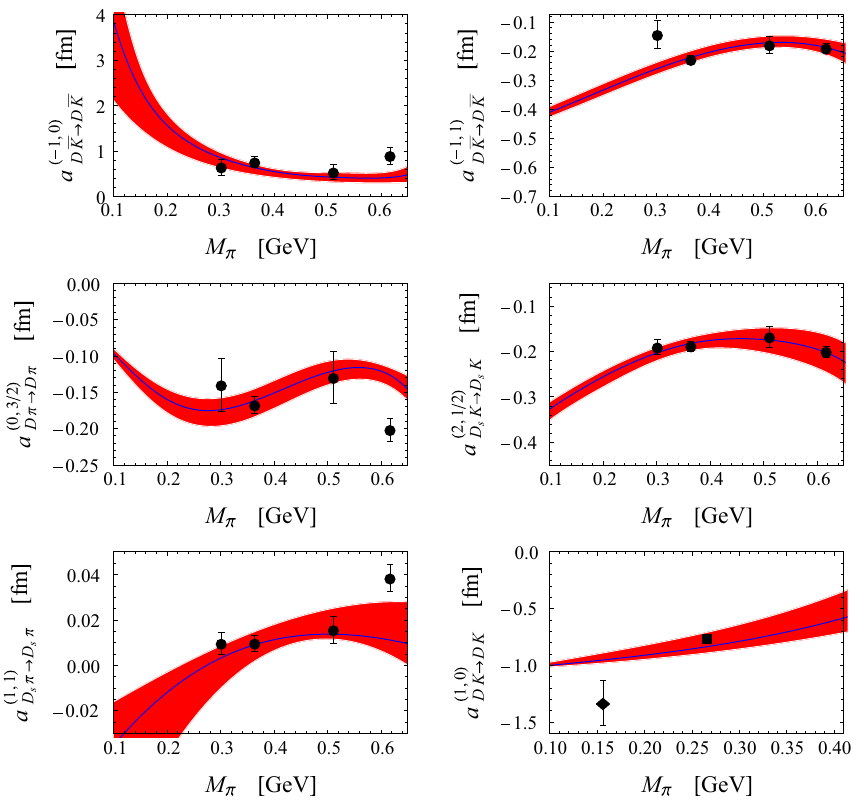
Fig. 2 The results of the UChPT-6(b) fits to the lattice data of the scattering lengths. The filled circles are lattice results in Ref. [25], and the filled square (not included in the fits because it refers to N f = 2) and diamond are taken from Ref.